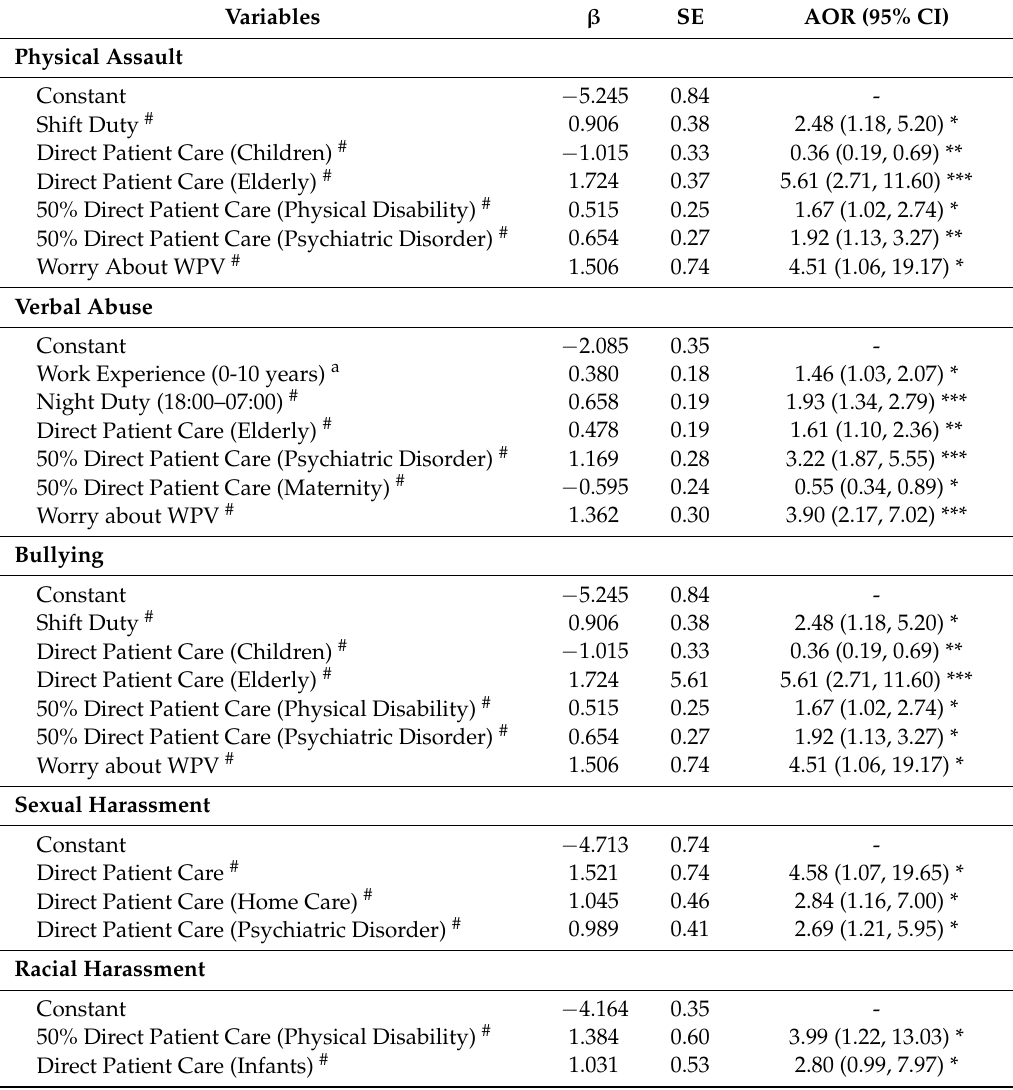
Table 5. Multivariate logistic regression model predicting physical assault, verbal abuse, bullying, sexual harassment, and racial harassment towards physicians and nurses in Macau. Variables